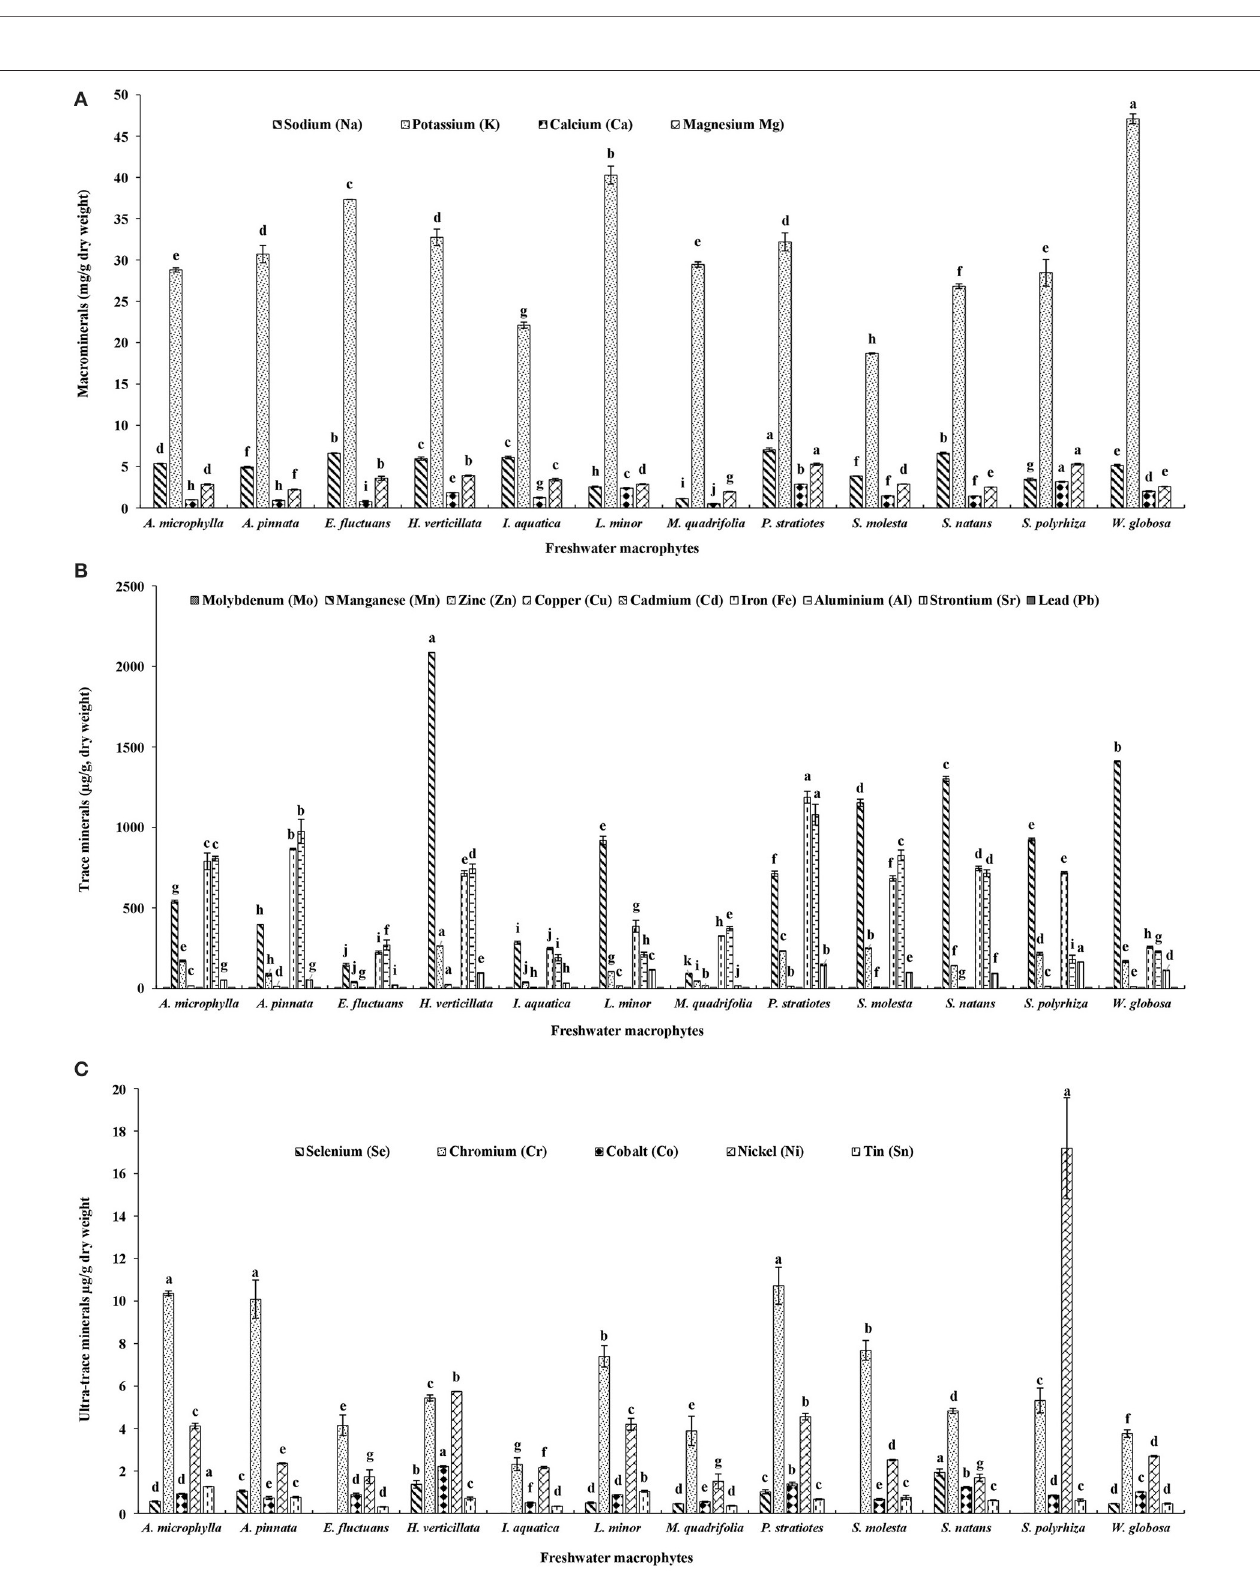
FIGURE 2 | (A) Macrominerals, (B) trace minerals, and (C) ultra-trace minerals contents of twelve freshwater macrophytes cultured with organic manures. Bars with different superscripts are significantly different ( n = 3).